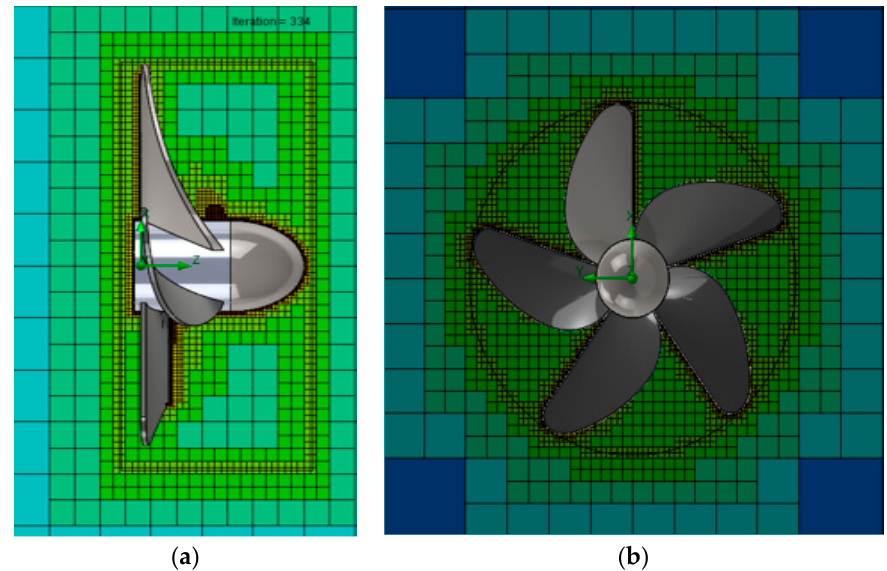
Figure 7. Computational Mesh around the rotor blade: ( a ) Side view; ( b ) Front view. Table 2. Meshing and boundary conditions.